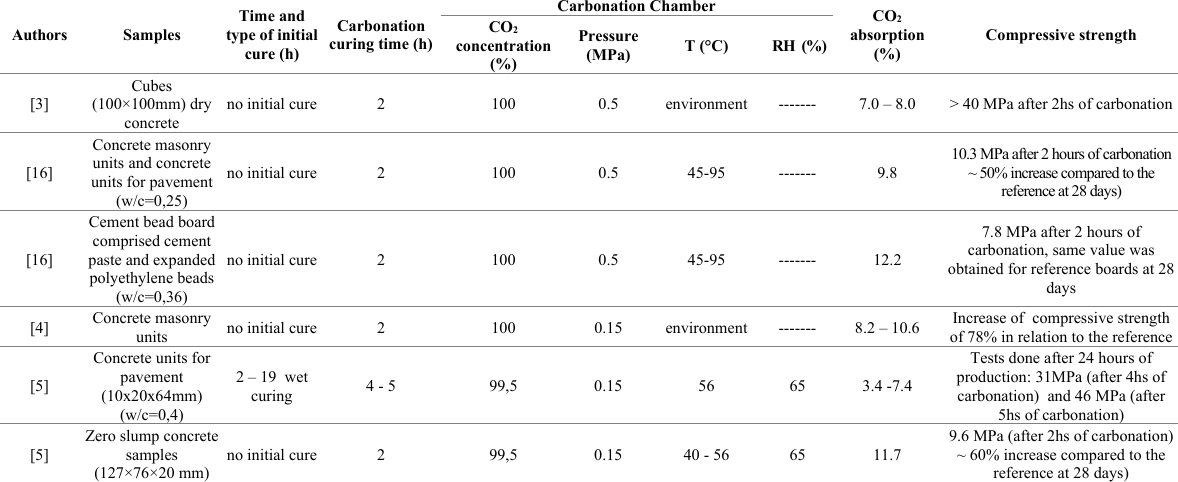
Table 1. Research involving accelerated carbonation curing in unreinforced cementitious